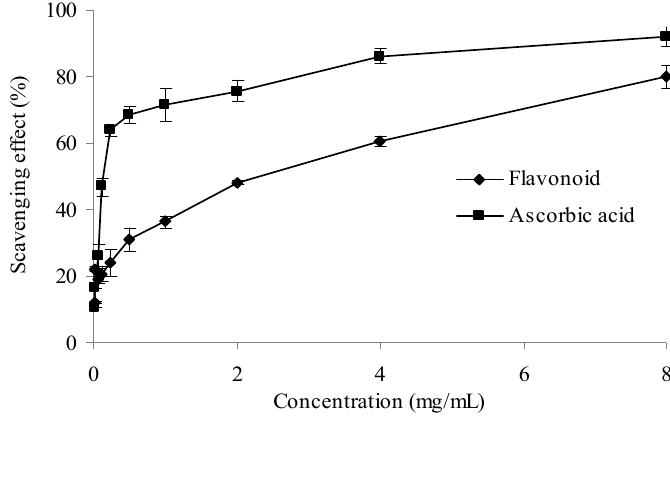
Figure 7. Superoxide anion scavenging activities of sample and control standards. Each value is expressed as a mean ± S.D (n =